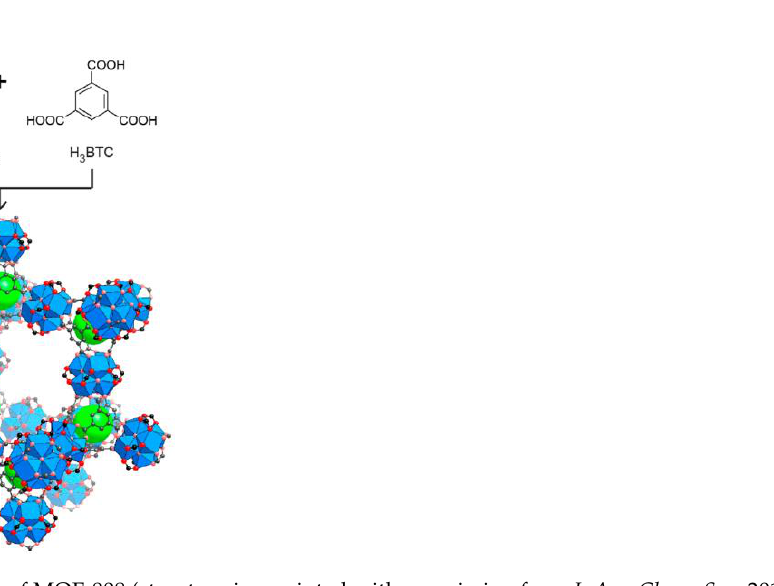
Figure 1. Synthesis of MOF-808 (structure is reprinted with permission from J. Am. Chem. Soc. 2014,